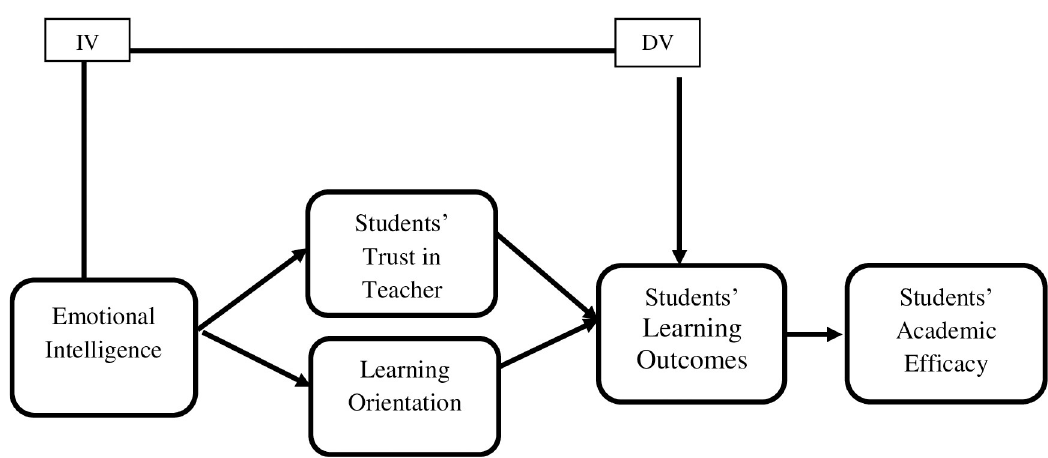
Fig 1. Conceptual framework. Note: IV = Independent Variable , DV = Dependent Variable